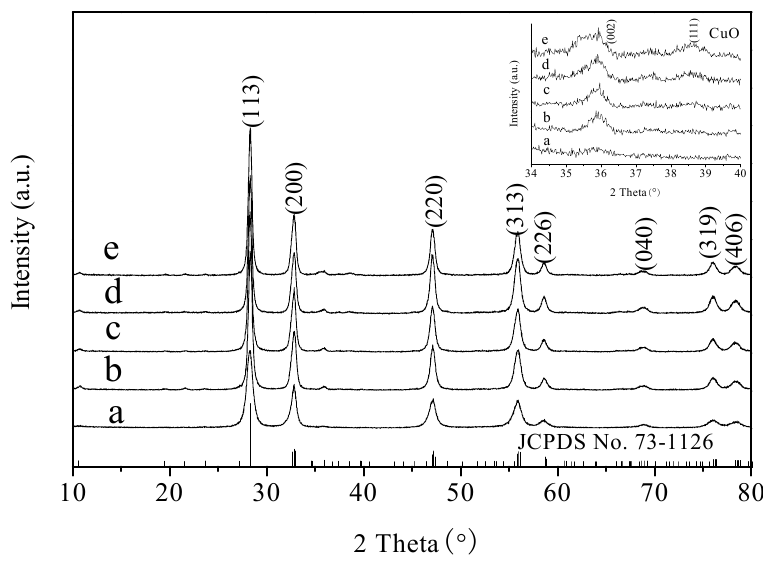
Figure 1. XRD patterns of Bi 2 WO 6 -400 and ( a ) Au–CuO/Bi 2 WO 6 -400; ( b ) Cu 1.64 wt %, Au 0.415 wt %; ( c ) Cu 3.27 wt %, Au 0.425 wt %; ( d ) Cu 4.85 wt %, Au 0.438 wt %; ( e ) Cu 6.61 wt % Au 0.448 wt %.